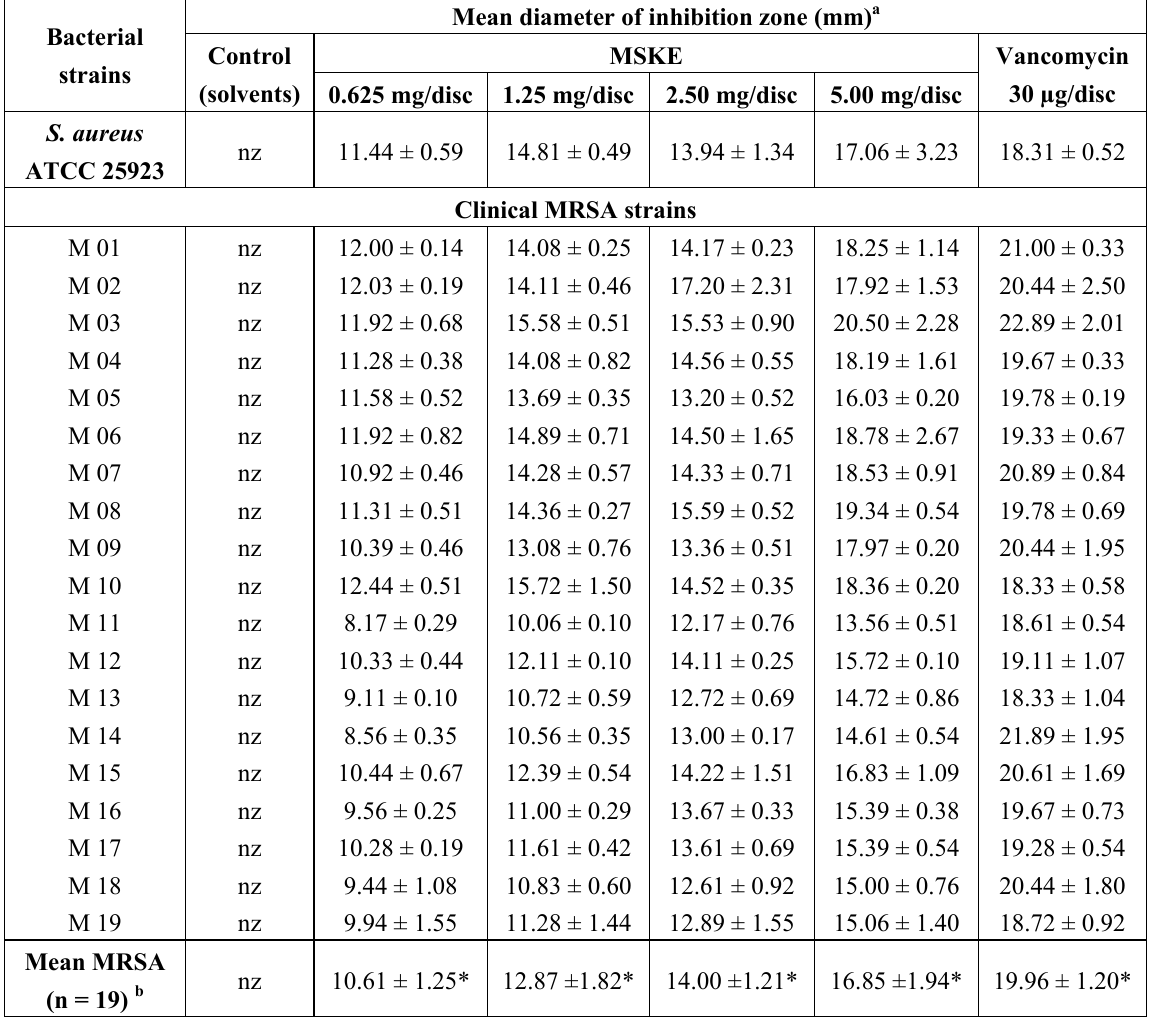
Table 1. Antibacterial activity of MSKE against S. aureus ATCC 25923 and 19 clinical MRSA isolates (nz = no inhibition zone, a mean values ± S.D. of triplicate results, b mean values ± S.D. from 19 MRSA strains, *no significant difference from S. aureus ATCC 25923 at p >